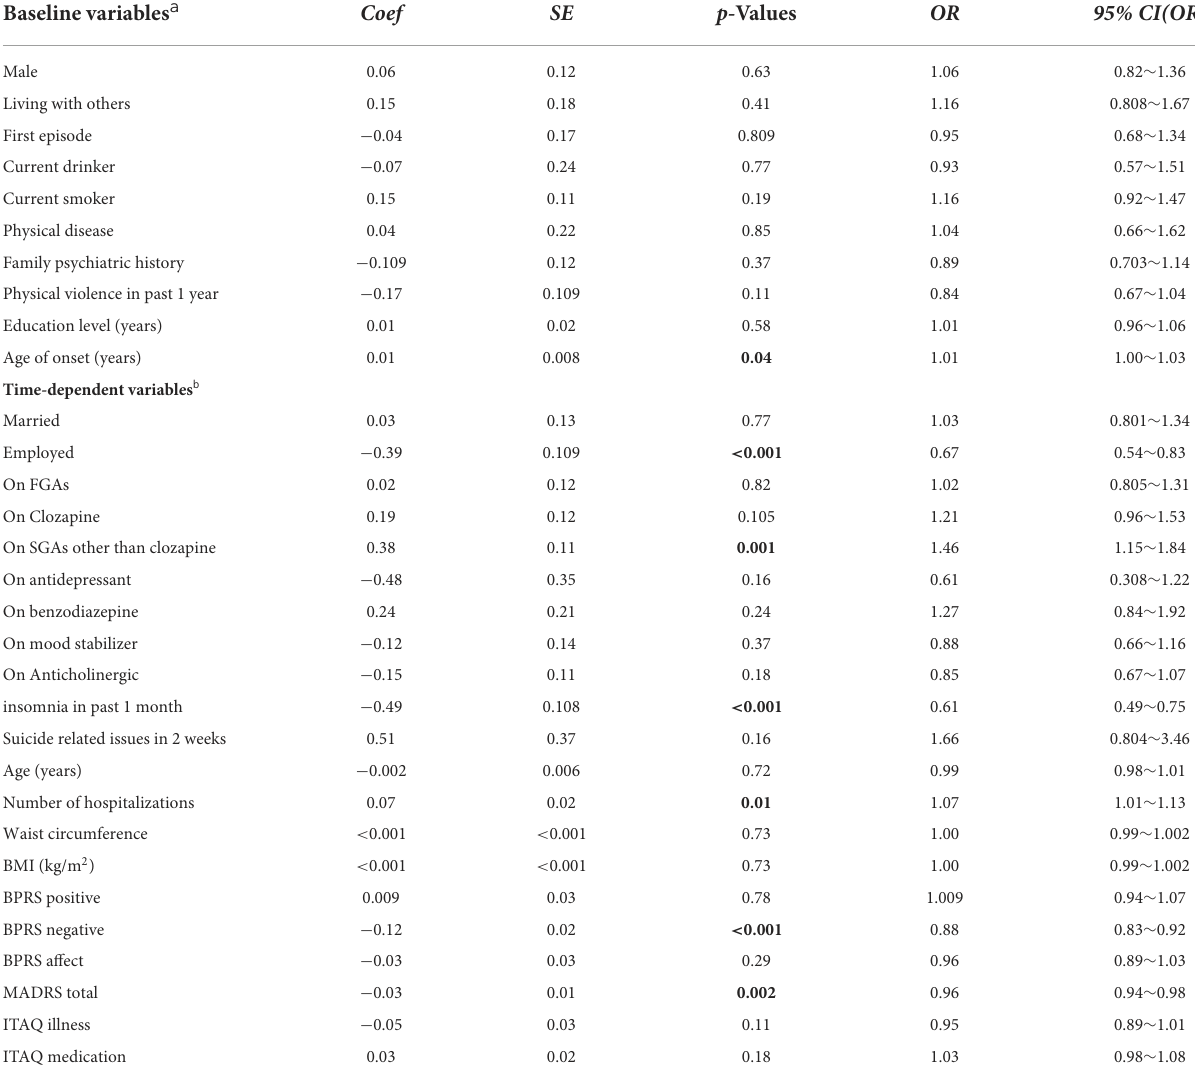
TABLE 4 Generalized Estimating Equations (GEE) results modeling risk factors associated with WHOQOL physical domain in 491 patients with schizophrenia. Baseline variables